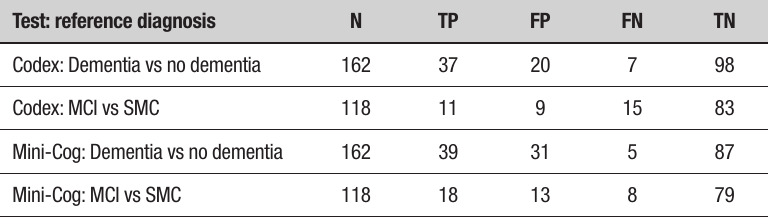
Table 2. Patient categorization by Mini-Cog and Codex as a function of the reference diagnosis.